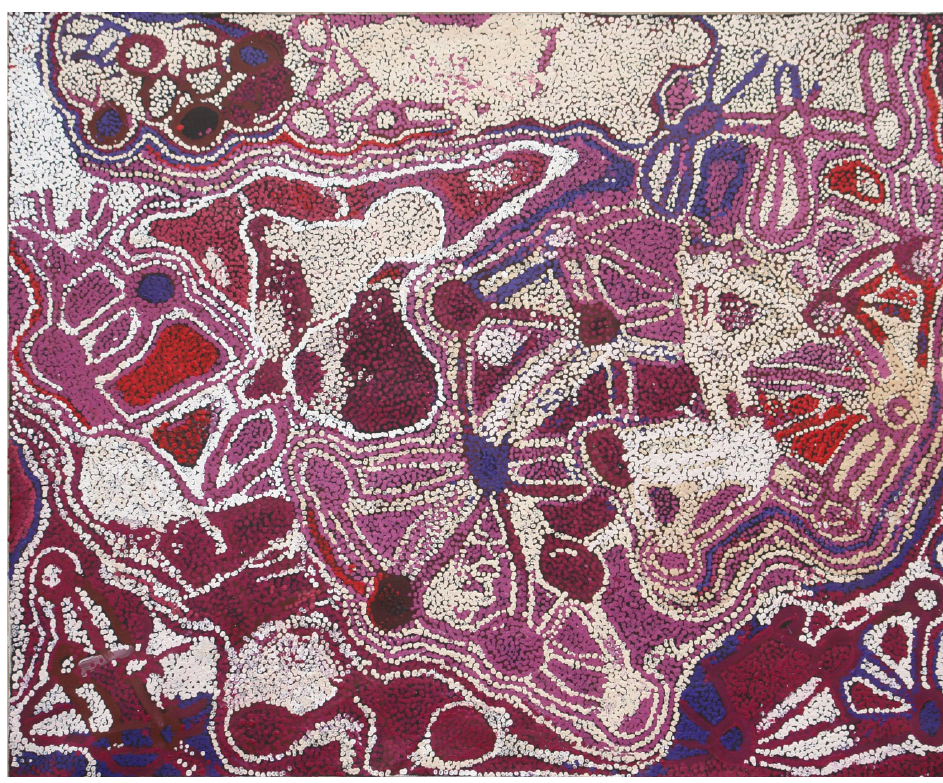
Tjaruwa Woods, Kamanti , 2009. Acrylic on canvas, 109 x 135.5 cm. The Lepley Collection